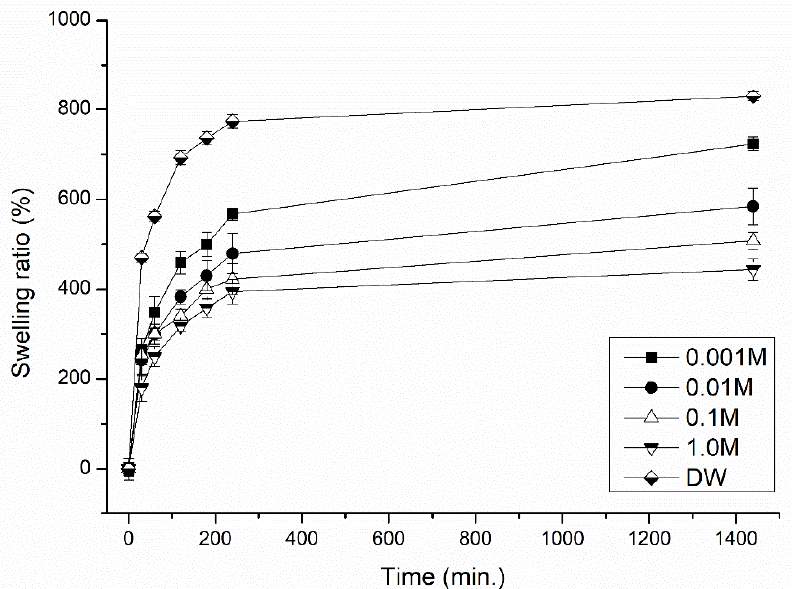
Figure 3. Dependence of ionic strength (concentration of salt) in water on the swelling behavior (SR %) of the hydrogel H5CA. Data refer to mean values ± SD (n = 3).